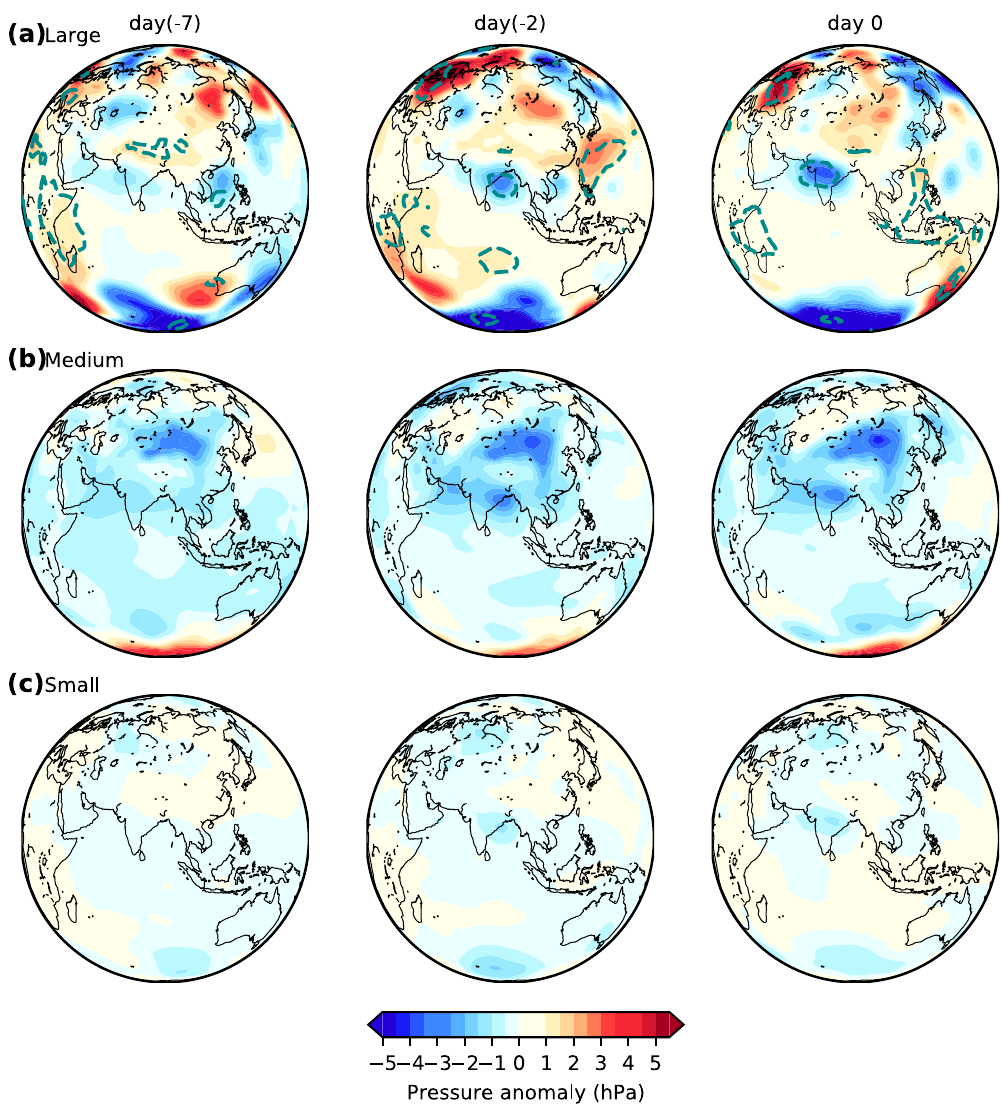
Figure 4. Surface pressure anomalies associated with rainfall extremes. Composite evolution of daily surface pressure anomalies for ( a ) large ( b ) medium and ( c ) small extreme rainfall events. Here, day 0 is the day of the Extreme Rainfall Event; day( − 2) and day( − 7) respectively indicate two and seven days before the event. The dotted contours indicate the regions that have significant anomalies at the 99% confidence level (using t-test). The data is obtained from the National Centers for Environmental Prediction (NCEP) reanalysis for the period